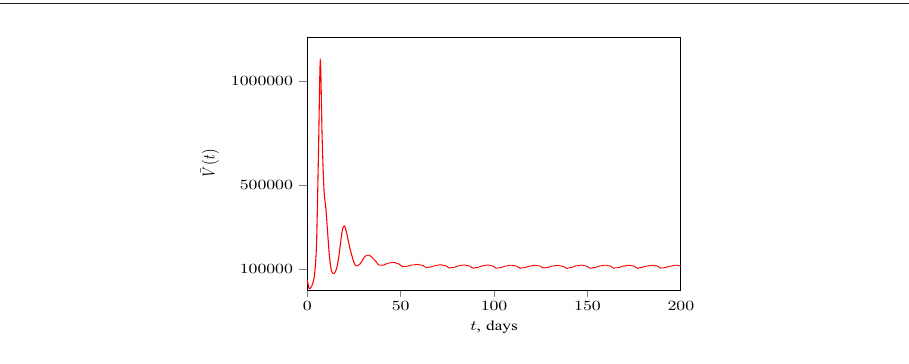
1 Figure 10. Dynamics of point estimates V ( t ) at experiment